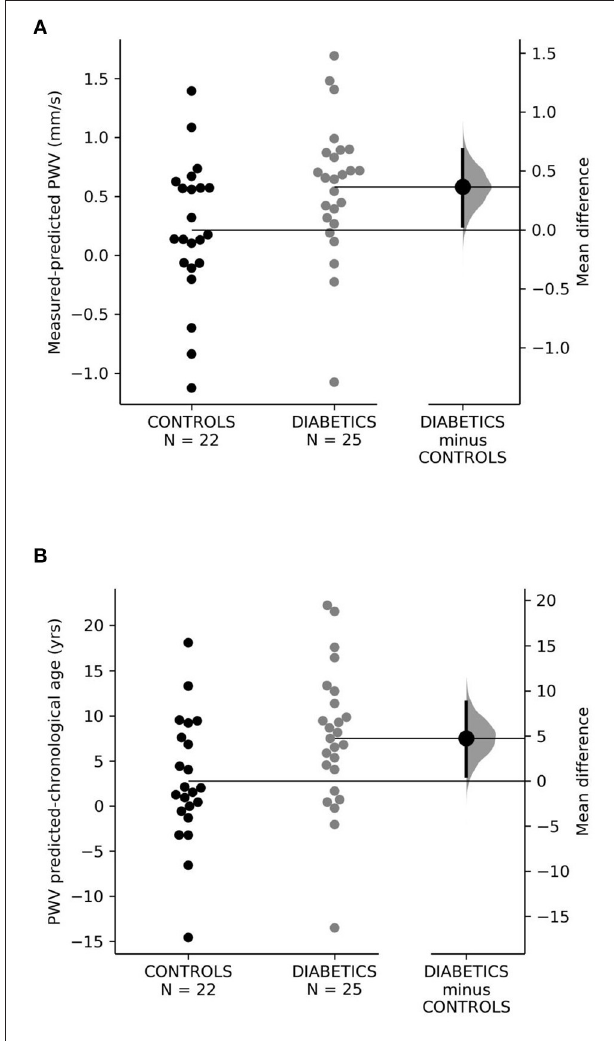
FIGURE 2 | (A,B) Vascular age. yrs,